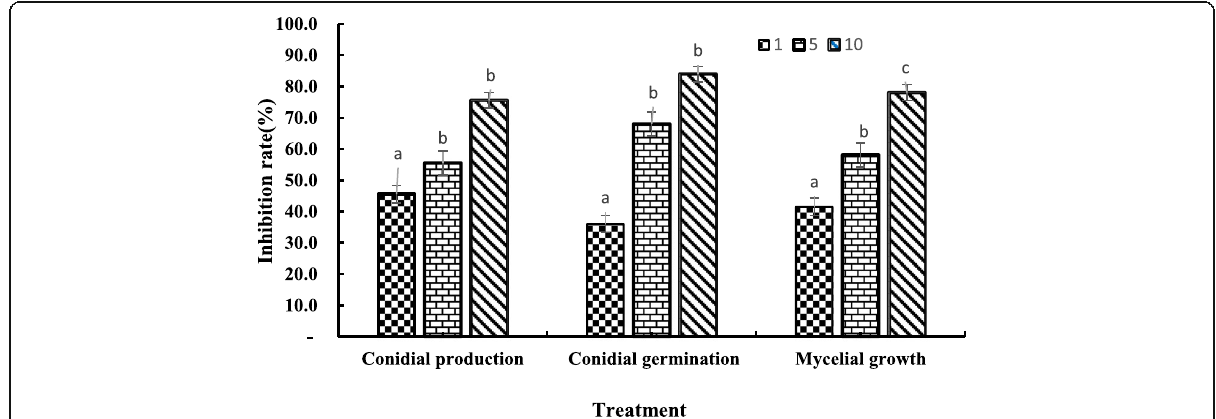
Fig. 2 Effect of extracellular culture supernatant of BM21 on mycelial growth, conidial germination, and conidial production of